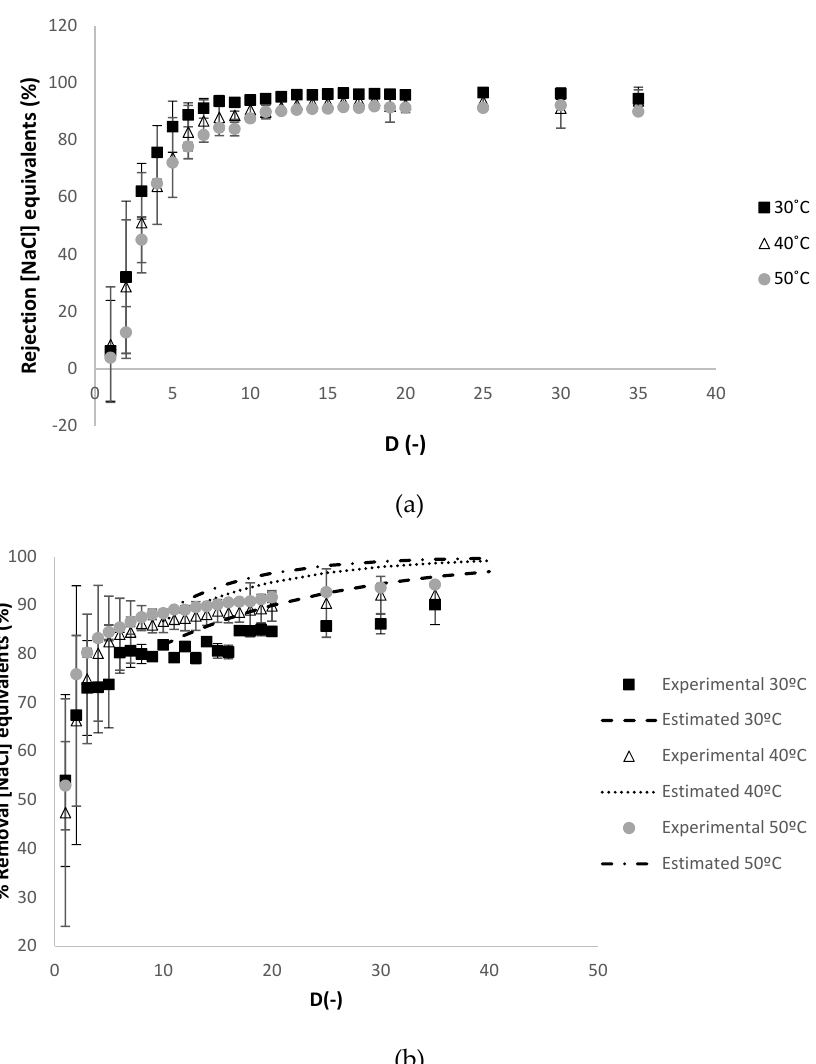
Figure 3. Dia-ultrafiltration experiment at 30 °C, 40 °C and 50 °C with (diluted) arabinoxylans fraction as feed, without relaxation procedure: ( a ) R NaCl (% NaCl.eq), apparent rejection in sodium chloride equivalents and ( b ) percentage of removal of charged contaminants in sodium chloride equivalents (NaCl.eq) against the D (-) diafiltration volume. Each analysis had duplicate measurements.